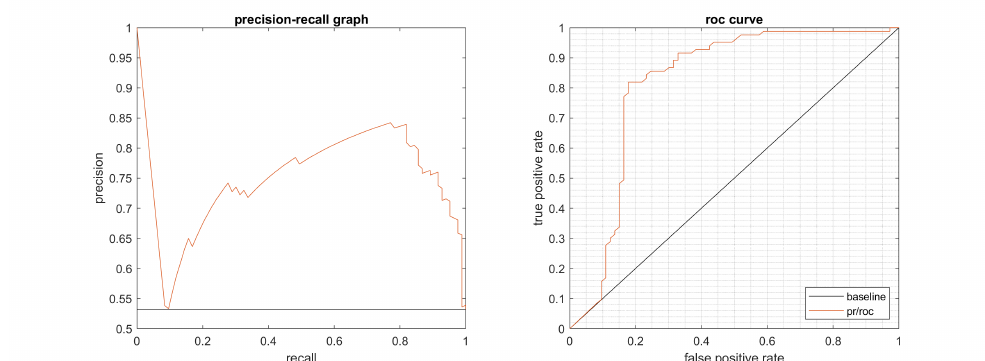
Figure 6. Precision-recall curve and receiver operating curve (Lithuanian voice dataset).